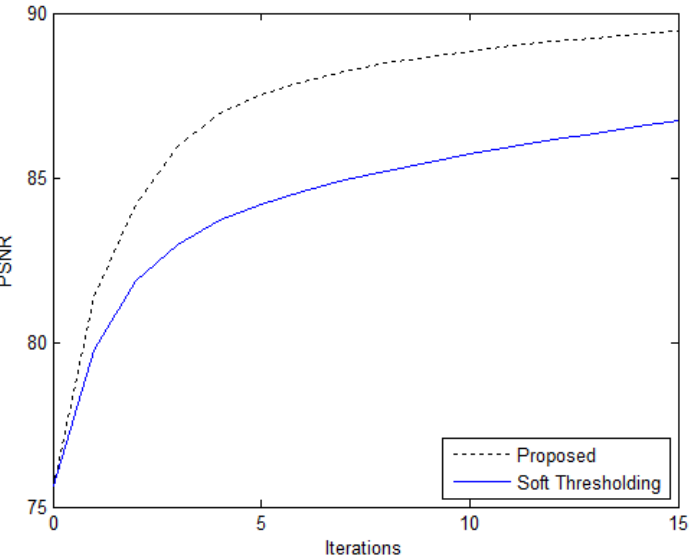
Figure 9. Correlation of proposed and soft thresholding algorithm of recovered compressively sample MR image.